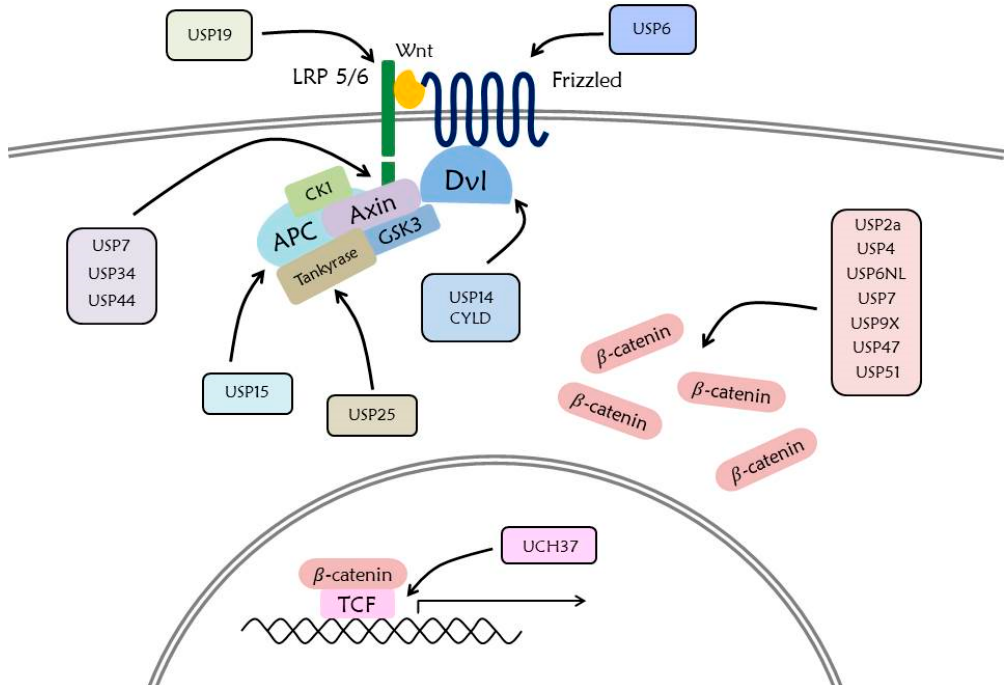
Figure 5. Deubiquitination in the Wnt signaling pathway. Deubiquitination of the Wnt signaling pathway by DUBs mainly functions to increase the stability of proteins, detaching ubiquitin from the target protein. DUBs associated with Wnt signaling pathway are mostly members of the USP family.